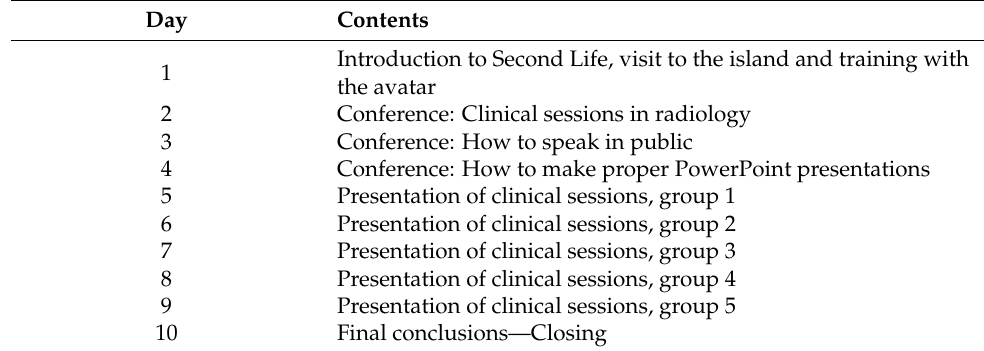
Table 1. Schedule of the clinical session